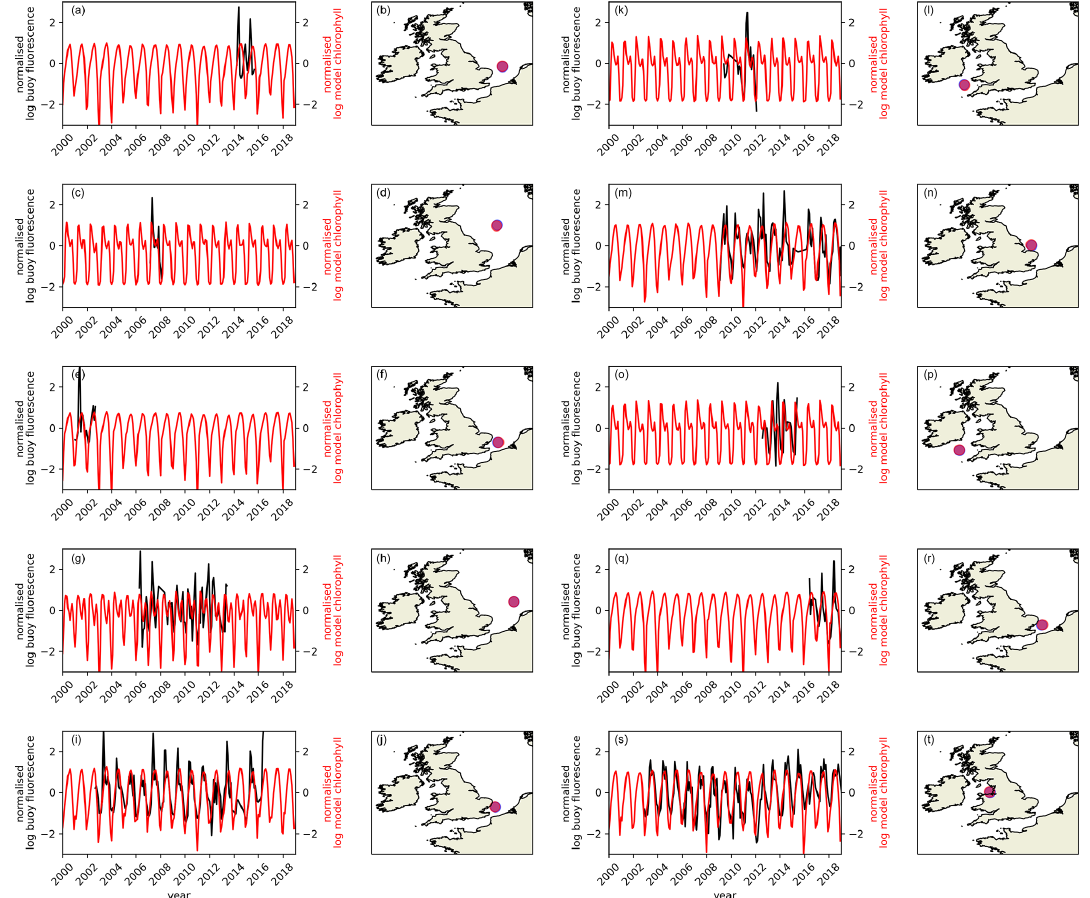
Figure 14. Comparison of model chlorophyll- a time series (red) with chlorophyll- a fluorescence measurements (black) made on 10 au- tonomous buoys situated round the UK as part of the Cefas SmartBuoy network (Sivyer, 2016). Both datasets have been averaged monthly and logged, had the time series mean removed and have been normalised by their standard deviation. Fluorescence data have been filtered to include only that collected between 18:00 and 06:00LT to avoid quenching of the signal by sunlight. Maps on the right-hand side illustrate the location of each buoy. Note that buoys have been operational over different time